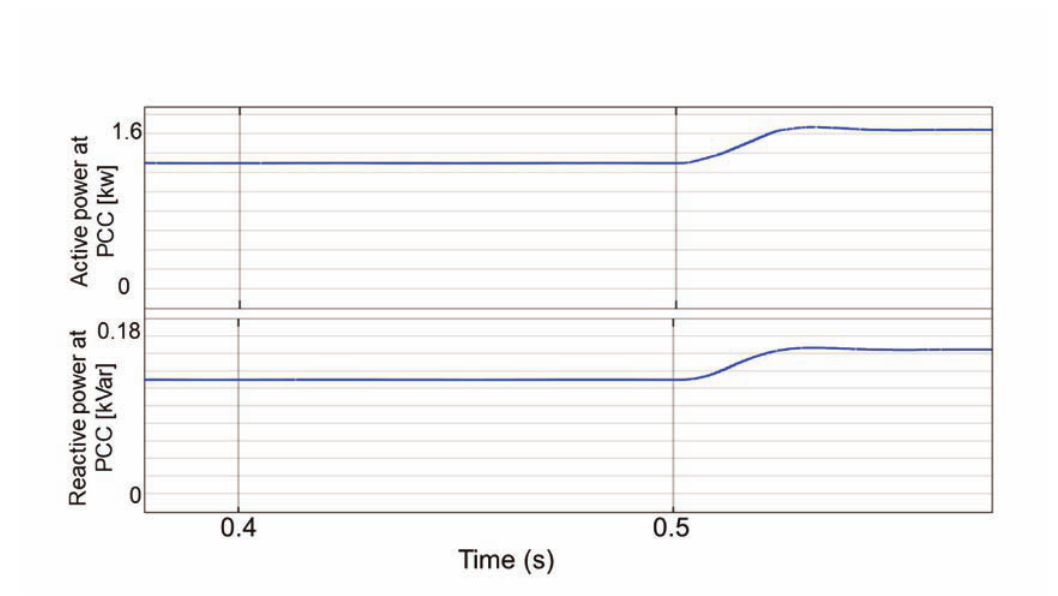
Table 1. Numerical results for Example 1